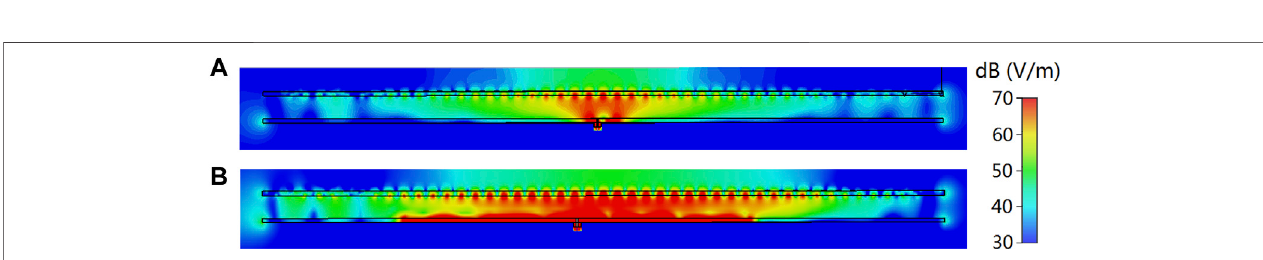
FIGURE 8 | Intensity distribution of the electric fi eld in the MNM antenna (cross section). (A) Single metallic patch as the radiation source of the antenna, which is same with that in Figure 3 . (B) Metallic patch array as the radiation source which is shown in Figure 6 .